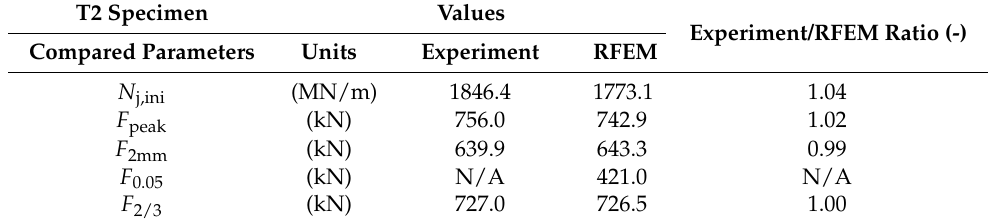
Table 3. Results of validation, T2.